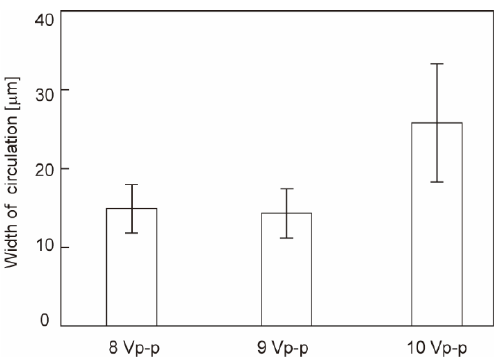
Figure 3. ACEO flow visualized by fluorescent microbeads. The width of circulation indicates the distance of movement of a microbead projected onto a horizontal plane. N = 4. Error bars show the standard deviation.